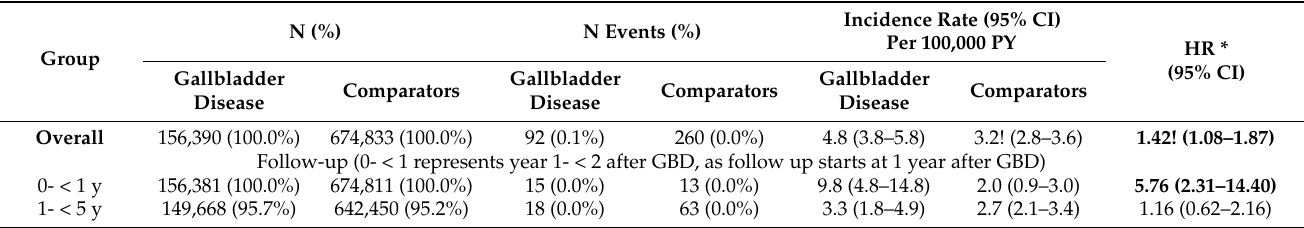
Figure 1. Relative risk of adenocarcinoma and carcinoid over time after study entry (i.e., time 0 equals 1 year after first gall bladder disease date). The fitted trend line represents a polynomial of 2 order. Table 2. Stratified risk of small bowel adenocarcinoma in individuals with gallbladder disease and matched general population comparators.